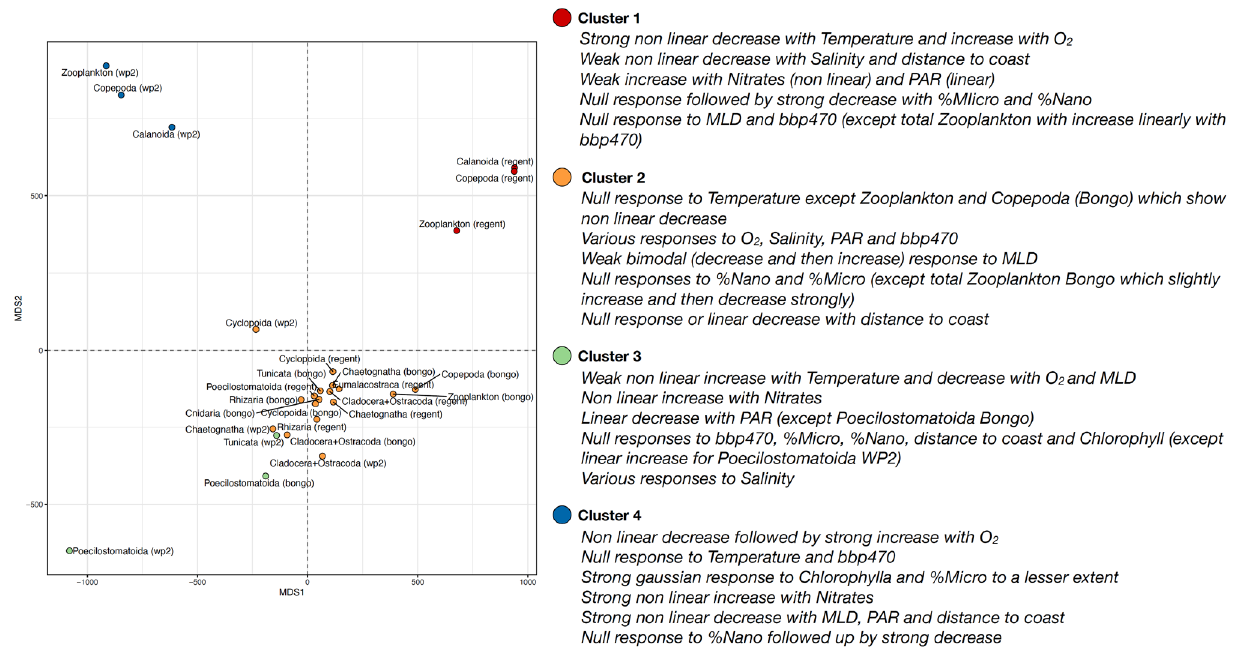
Figure 6. Two dimensional metric dimensional scaling (MDS) plot illustrating the similarity between the responses of the groups ’ abundances to the environmental covariates selected. The smoothing curves from the Generalized Additive Models (GAMs) modelling the global gradients in cubic-transformed abundances (ind m 3 ) of the zooplankton groups (estimated for various plankton nets) as a function of ten environmental covariates and displaying a deviance explained > 40%. Smoothing curves span a 1 – 100 scale spanning the range of the covariates measured values. The smoothing curves were combined into a multivariate data series to compute Dynamic Time Warping (DTW) distances and perform partitioning around medoids